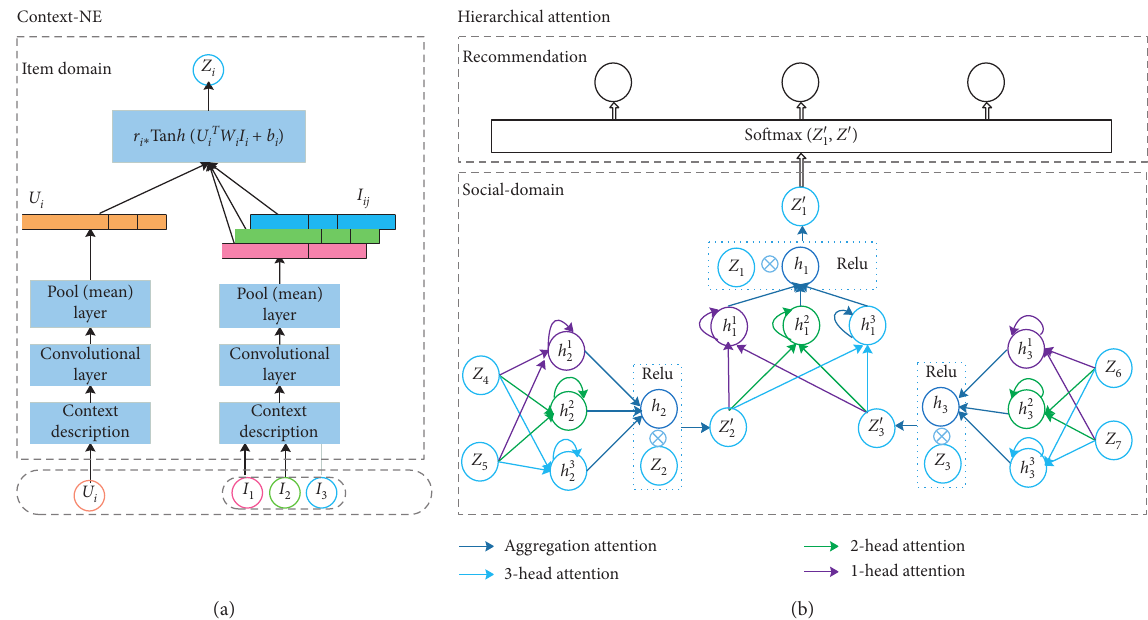
Figure 2: The framework of HA-RS model in this paper. (a) The user’s node representation model Context-NE in the item domain. (b) The hierarchical attention embedding model, which is used to learn the feature of user